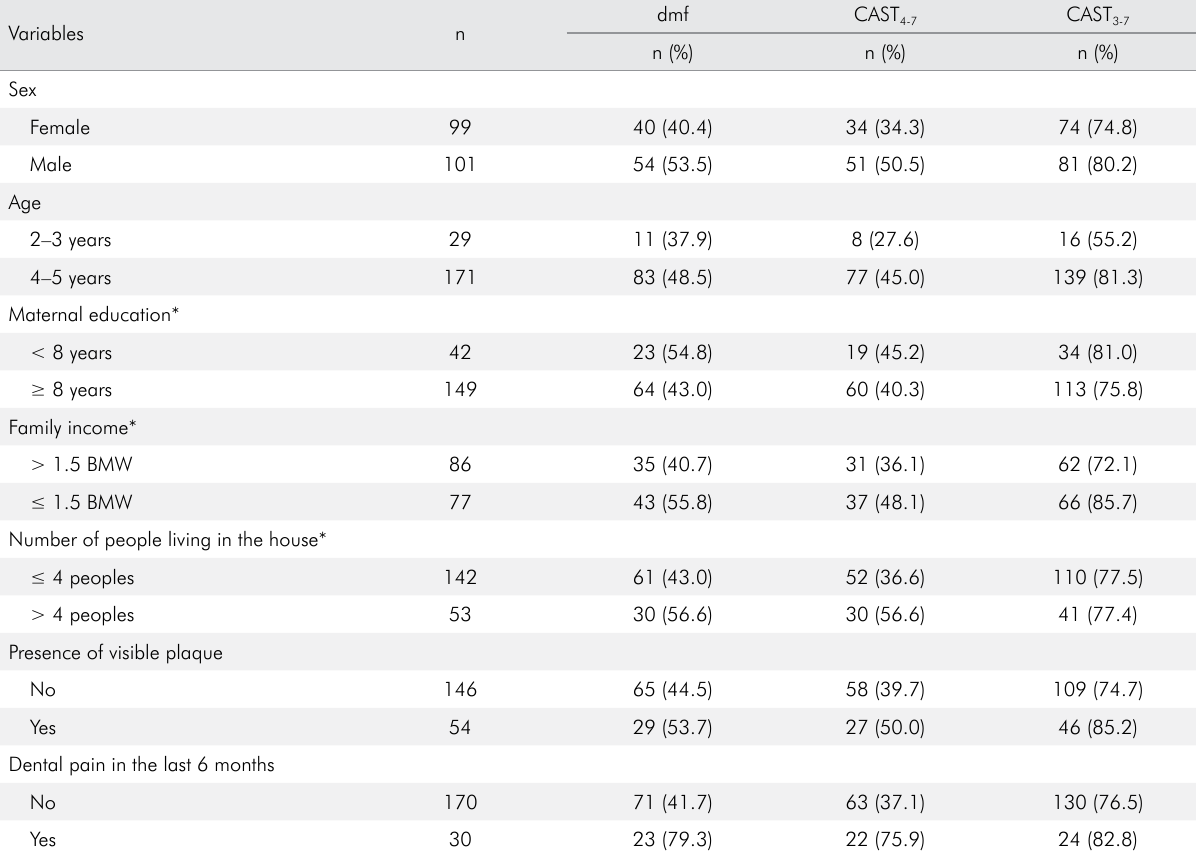
Table 1. Prevalence of caries according to the CAST at thresholds CAST variables (n =